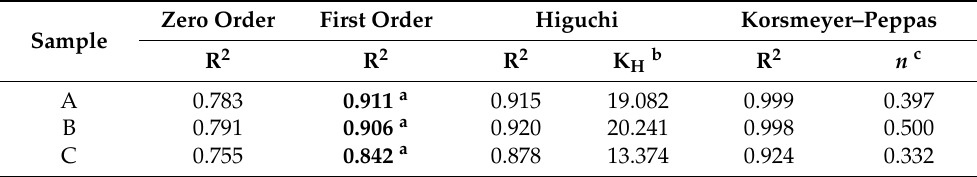
Table 4. Data analysis of 5-FU release from